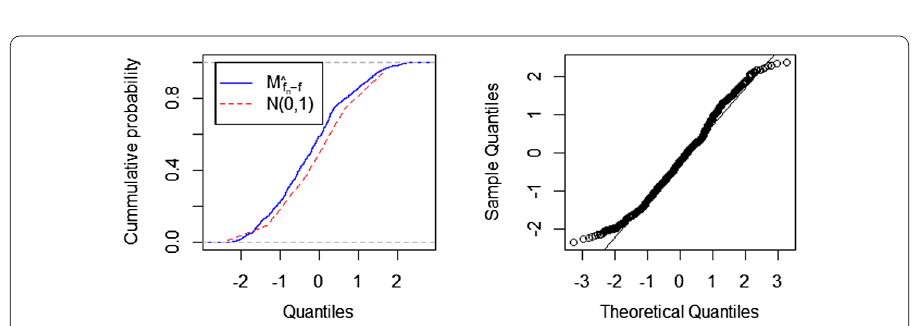
and N (0,1), and QQ-plot of M ˆ fn – f